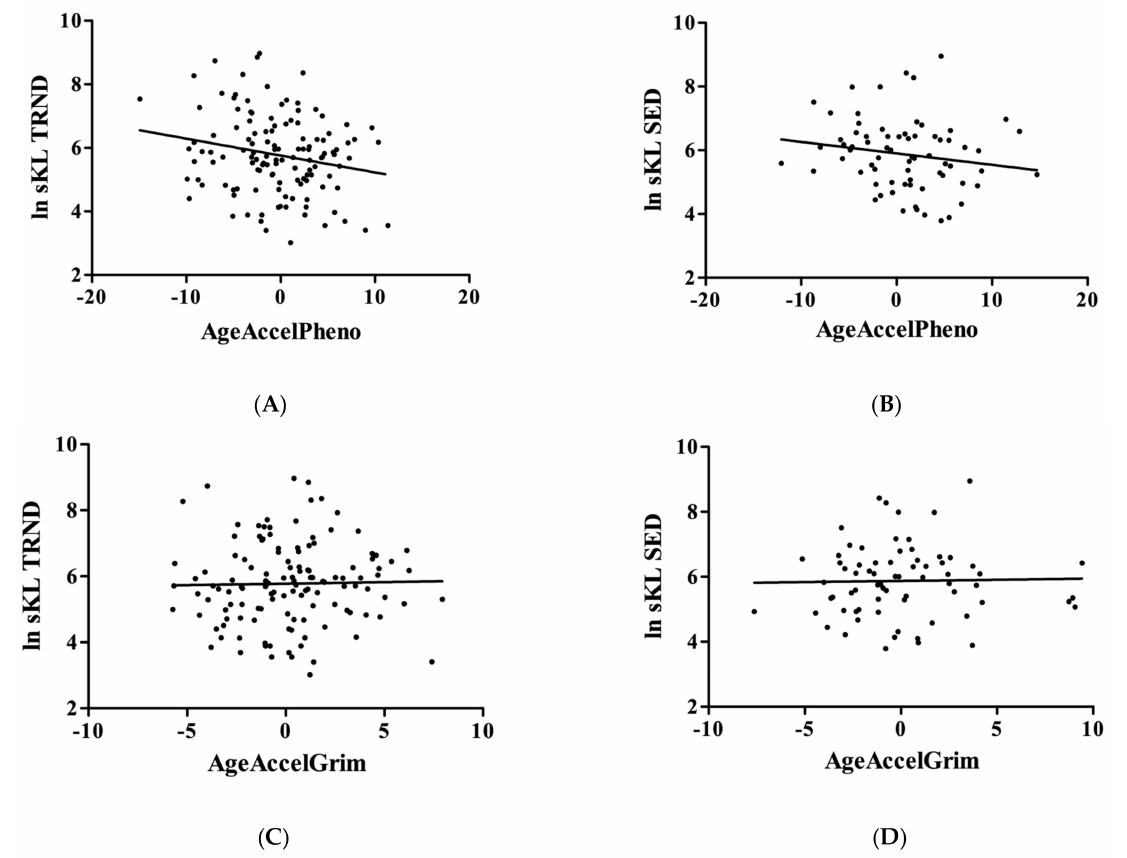
Figure 4. The correlation between KL and DNAmPhenoAge and DNAmGrimAge. The epigenetic aging was calculated on the DNA methylation pattern based on the description of DNAmPhenoAge and DNAmGrimAge. KL is associated with PhenoAge acceleration in the TRND group (Panel ( A ), N = 131), not in the SED group (Panel ( B ), N = 71). However, GrimAge acceleration did not show a significant relationship with KL in either group (Panel ( C ), N = 131; Panel ( D ), N =